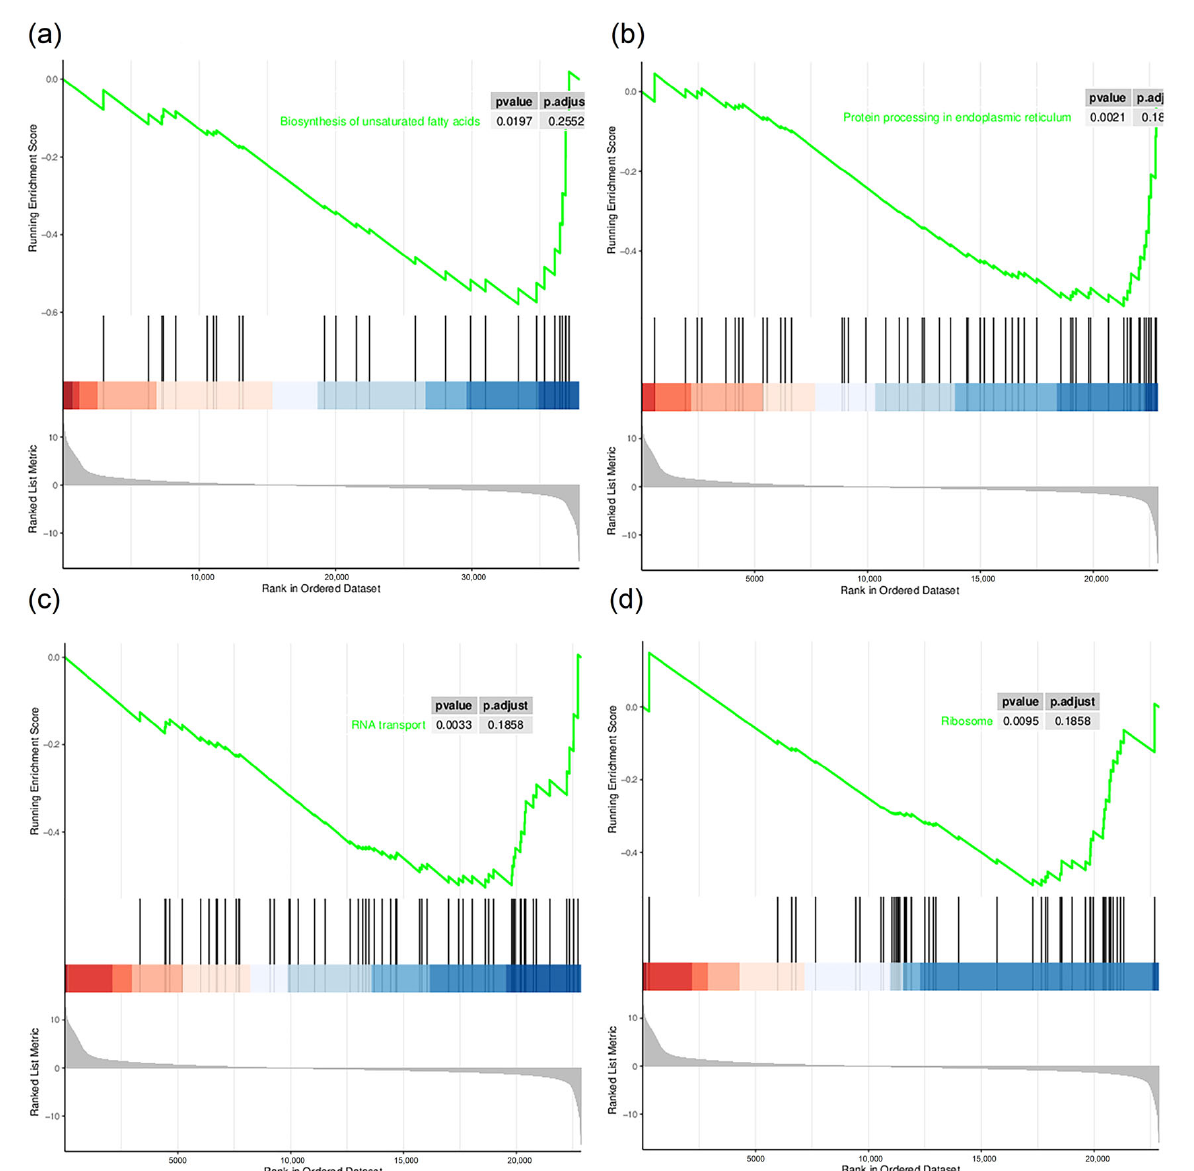
Figure 6. GSEA of downregulated pathways in gregarious armyworms compared with solitary armyworms. The interpretation method of figures is the same as that in Figure 5. ( a ) Biosynthesis of unsaturated fatty acids; ( b ) protein processing in the endoplasmic reticulum; ( c ) RNA transport; ( d ) ribosome.